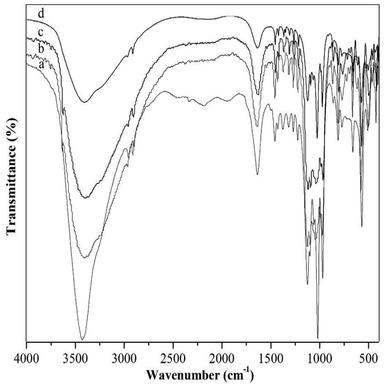
FTIR spectra of as-synthesized STA-12(M) samples: Mn (a), Fe (b), Co (c), Ni (d).